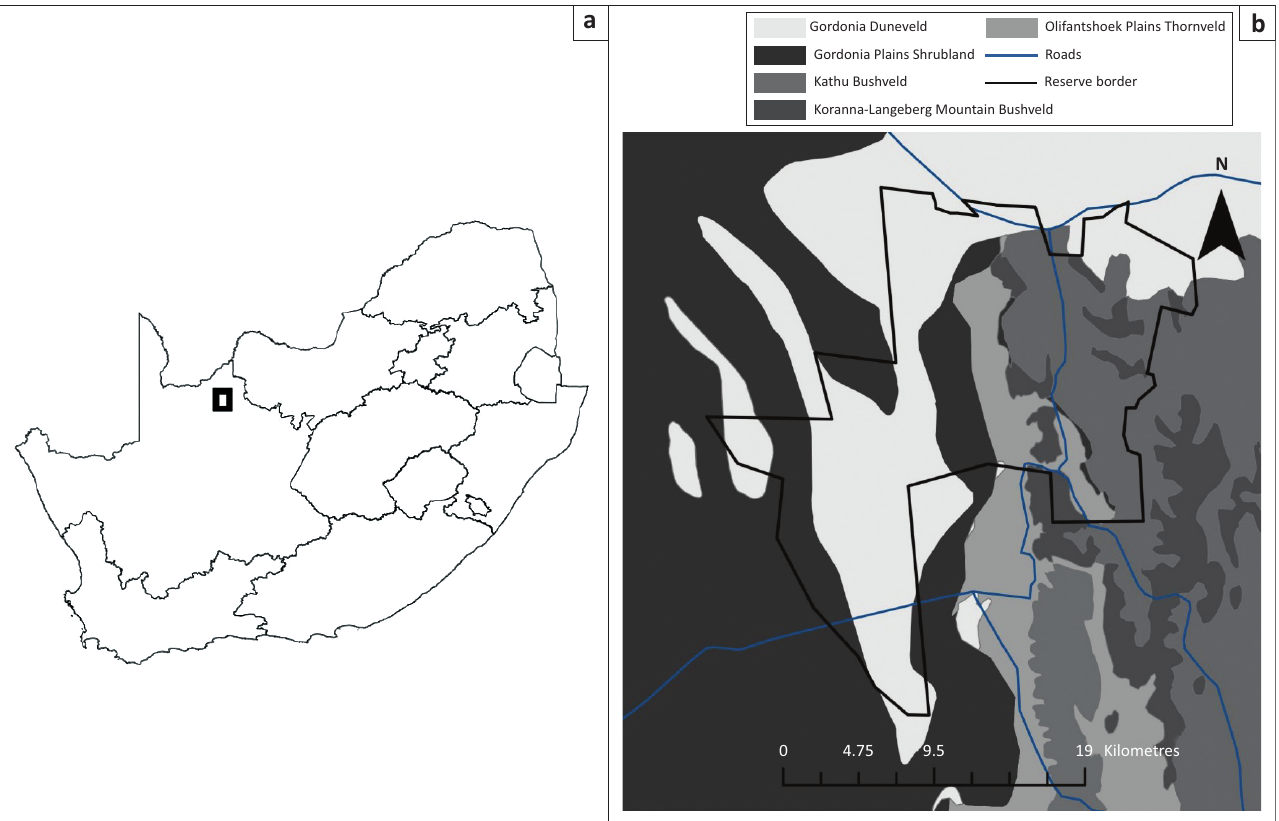
FIGURE 1: (a) Map of South Africa, showing the locality of the Tswalu Kalahari Reserve in Northern Cape province; and (b) details of the vegetation units in the